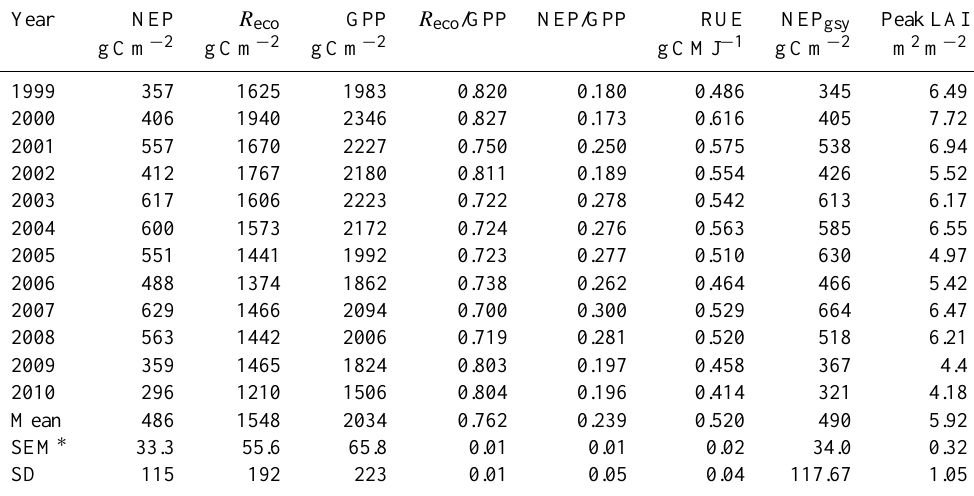
Table 3. Annual values 1999–2010 of carbon flux components for the oak plantation at the Straits Inclosure in Alice Holt Forest. Radiation- use efficiency (RUE) is calculated as GPP/incident solar radiation. NEP gsy is the sum of NEP in the growing season year, i.e. 1 April through to 31 March in the following year. Peak LAI was back calculated from cumulative LAI measured using litterfall traps sampled bi-weekly.